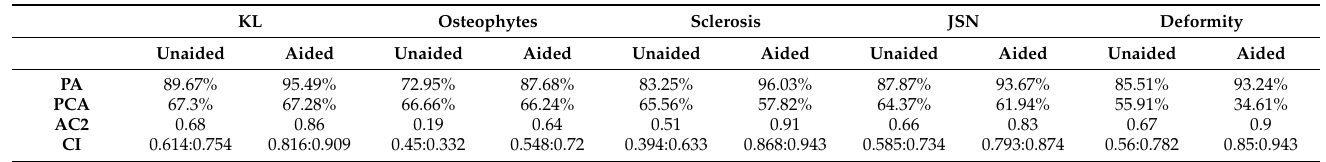
Table 4. Numerical values of inter-rater reliability analysis (AC2 = agreement coefficient estimate; CI = confidence interval; PA = percentage agreement; PCA = percentage chance agreement).